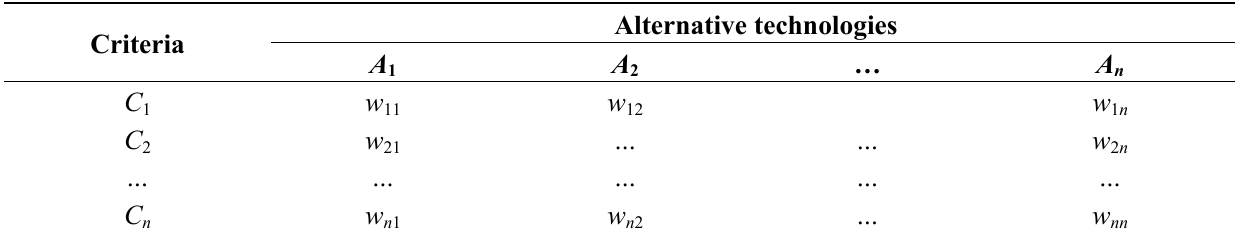
Table 2. Multi-criteria analysis (MCA) decision matrix